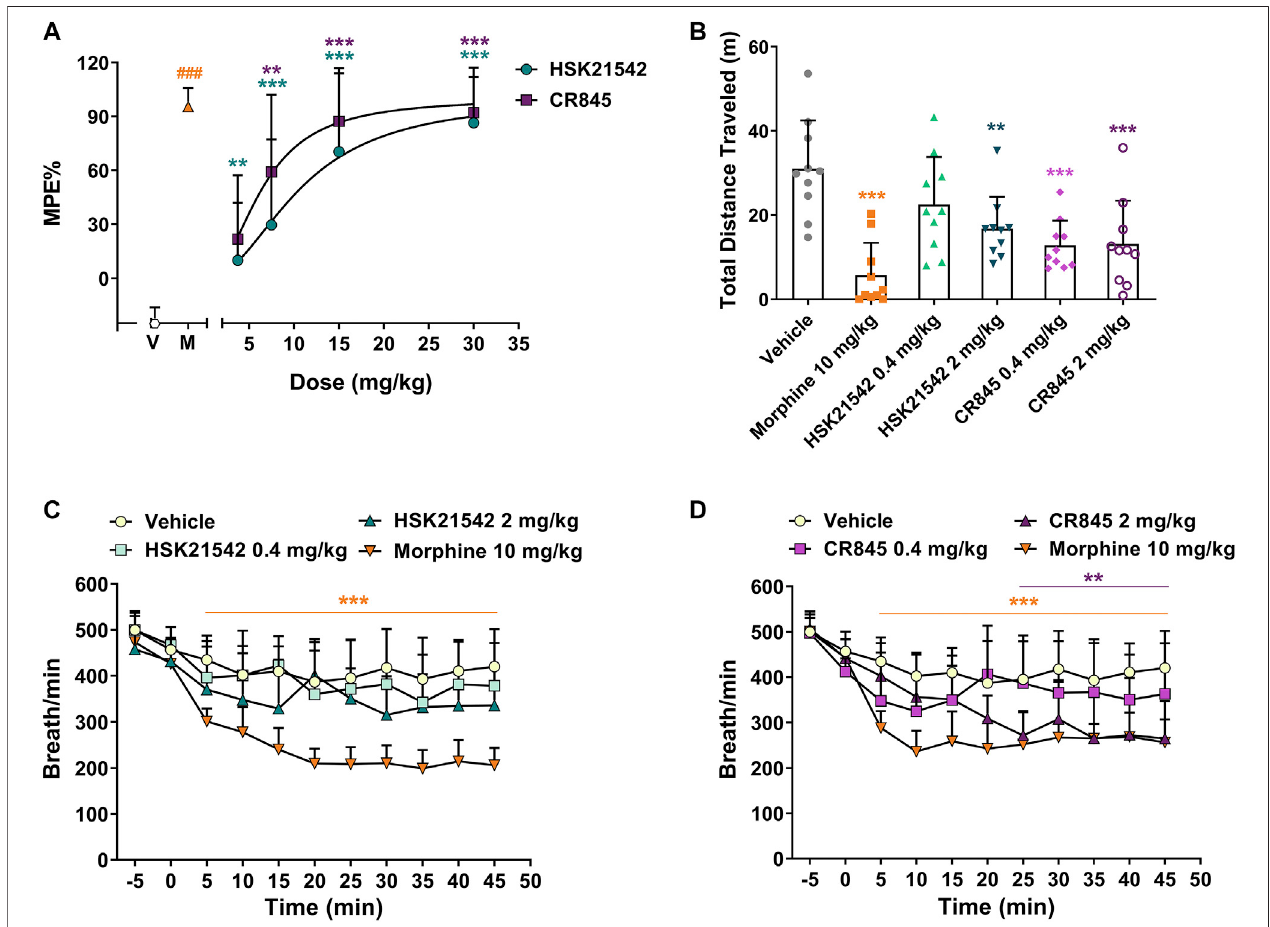
FIGURE 6 | Central antinociceptive activities, and effects on locomotor activity and respiratory rate of HSK21542 and CR845 in mice. (A) The central antinociceptive activities were evaluated using a hot-plate test in mice at 15 min post-drug. (B) The sedative effects at 15 min post-dosing were detected using a locomotor activity test. (C, D) The effects on respiratory rate in mice were measured with whole body plethysmography. Data are presented as means ± SD ( n (cid:1) 10/ group). (A,B) ** p < 0.01,*** p < 0.001vs.vehicle,one-wayANOVAfollowedbyDunnett ’ stest; (C,D) ** p < 0.01,*** p < 0.001vs.vehicle,two-wayANOVAfollowed by Dunnett ’ s test; ### p < 0.001 vs. vehicle, Mann-Whitney test. V, Vehicle; M, Moprhine (10 mg/kg, a positive control).